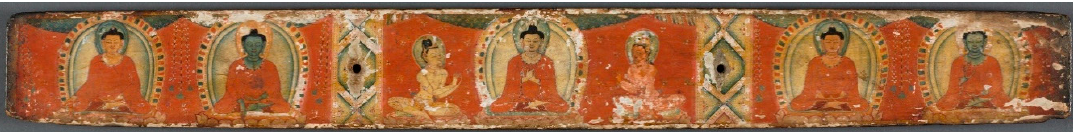
Figure 13. Four bodhisattvas and two attendants flanking Vajrasattva, bottom cover. Perfection of Wisdom in Eight Thousand Lines: A ṣṭ as ā hasrik ā Prajñ ā p ā ramit ā -s ū tra , 1119. Nepal. Gum tempera on wood. Overall: 6.5 × 57 × 1.5 cm. Cleveland Museum of Art, purchase from the J. H. Wade Fund, 1938.301.7. 17 The leftmost has a solar disk ( cakra ) on his lotus flower, while the rightmost has a crescent moon. The bodhisattva on the inner left has a blue lotus ( utpala ), while the one on the inner right has what appears to be flaming triple jewels on a white lotus. Their identity remains uncertain. It is interesting to note, however, that the leftmost bodhisattva is iconographically identical to the bodhisattva on the right of folio 90r (Figure 5).